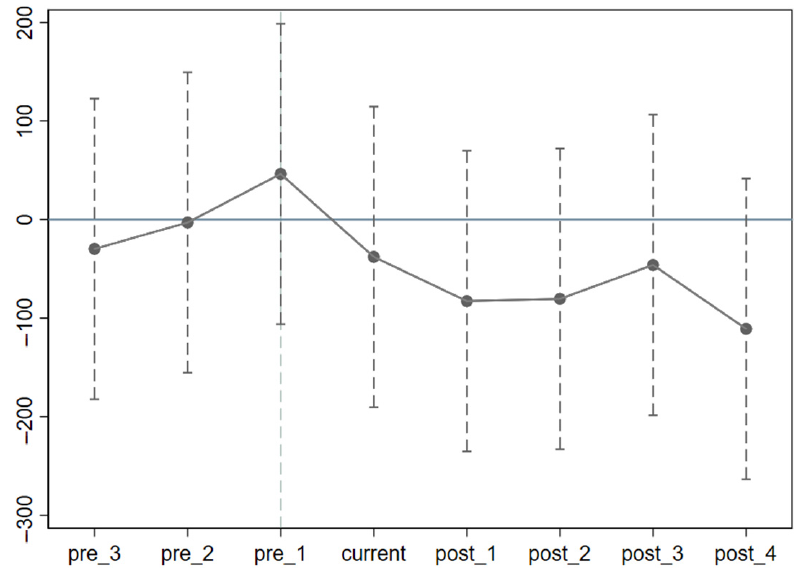
Figure 1. Parallel trend test.